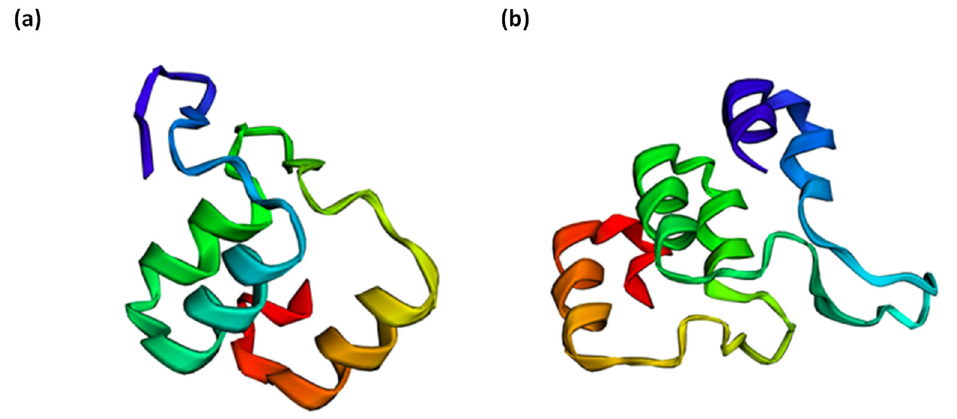
Figure 3. ( a ) Top model for the protein structure of the allele T (GORK gene), which belongs to a part of the ankyrin repeat domain, whose codon gives rise to the basic amino acid, lysine. Sixty-four residues (63% of the sequence) were modelled with 99.8% confidence by the single highest scoring template. ( b ) Top model for the protein structure of the allele A (GORK gene), which belongs to a part of the ankyrin repeat domain, whose codon gives rise to the non-polar amino acid methionine. Eighty residues (78% of the sequence) were modelled with 99.8% confidence by the single highest scoring template.